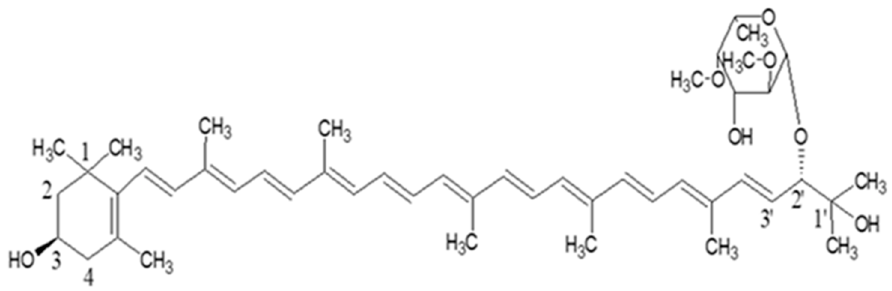
Figure 1. Chemical structure of myxoxanthophyll.